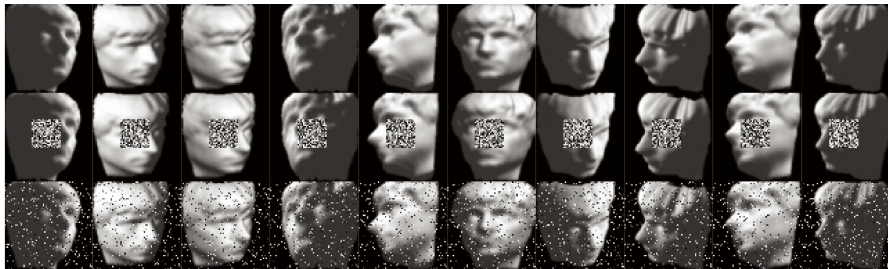
Figure 9. Ten ISOFACE images, their corresponding outlier images and noise-corrupt images.